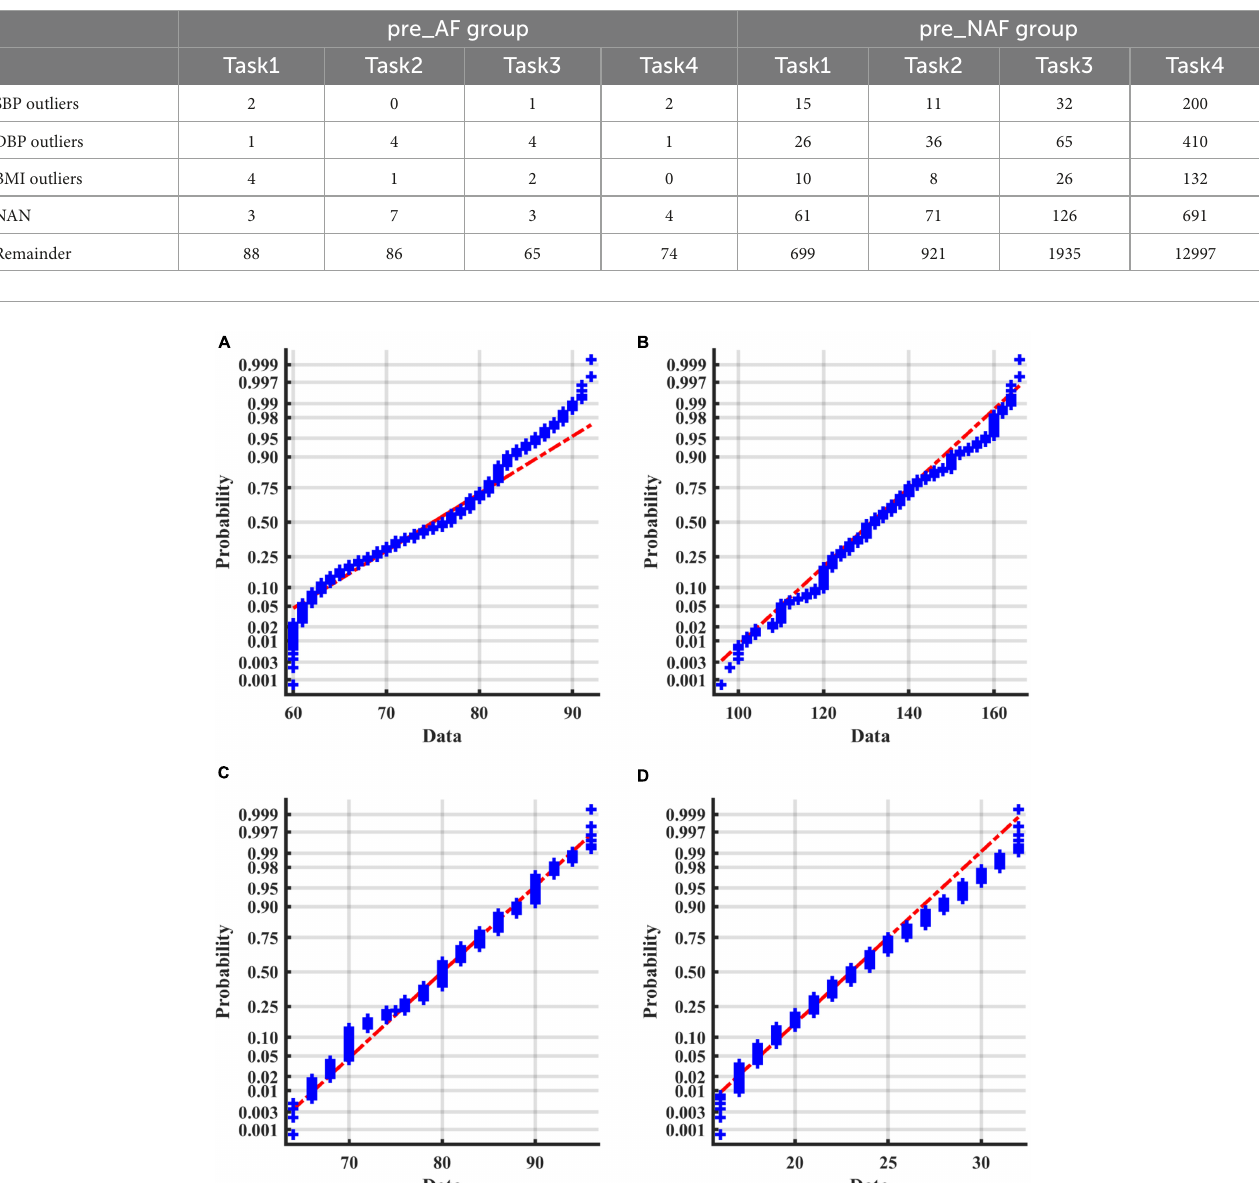
TABLE 2 The number of outliers and number of remaining samples in pre_AF group and pre_NAF group.